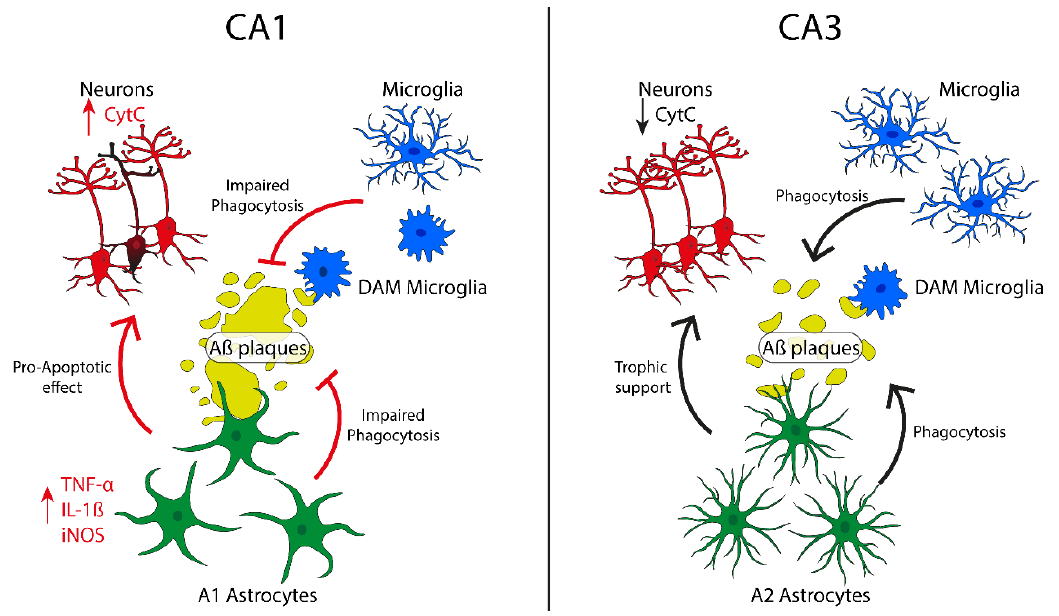
Figure 2. Schematic representation of the regional differences in CA1 and CA3. DAM: disease- associated microglia.